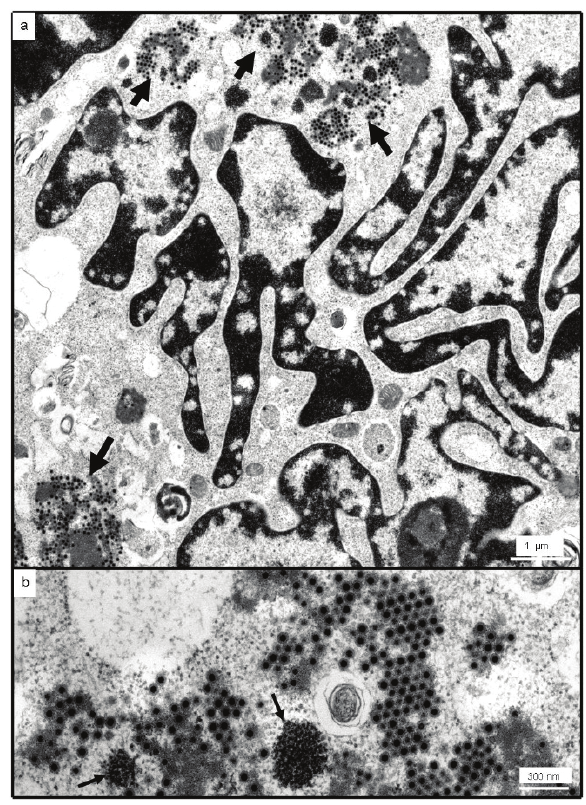
Figure 6. Vero E6 cells infected with MAHLV isolate 06-24. ( a ) multinucleate cells with lobed nuclei and scattered cytoplasmic inclusion bodies (arrows); ( b ) para-crystalline arrays of bi-layered virions developing from amorphous, grey inclusion bodies which were consistently associated with osmiophilic deposits resembling clusters of large ribosomes (arrows).